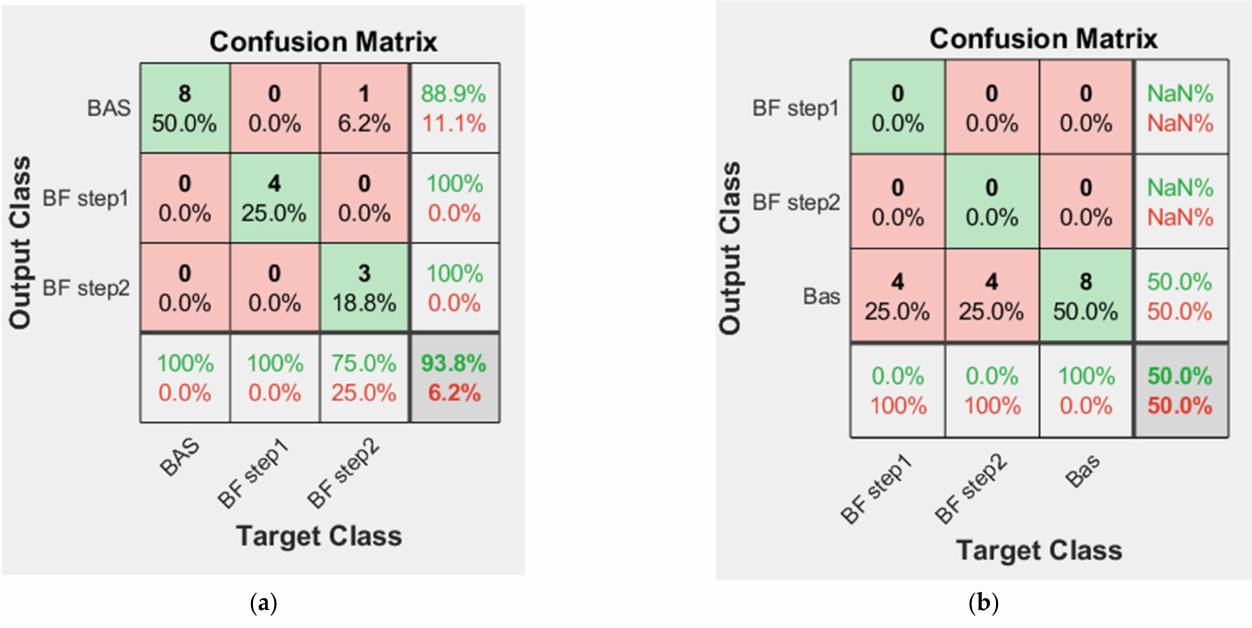
Figure 7. Confusion matrices (test set) for ( a ) radial flux signal and ( b ) for current